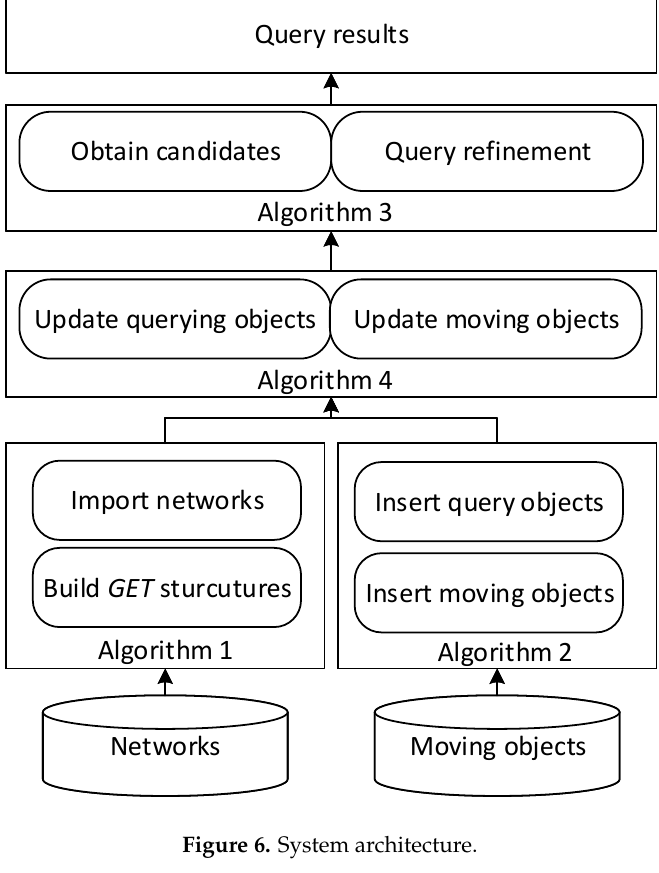
Figure 6. System